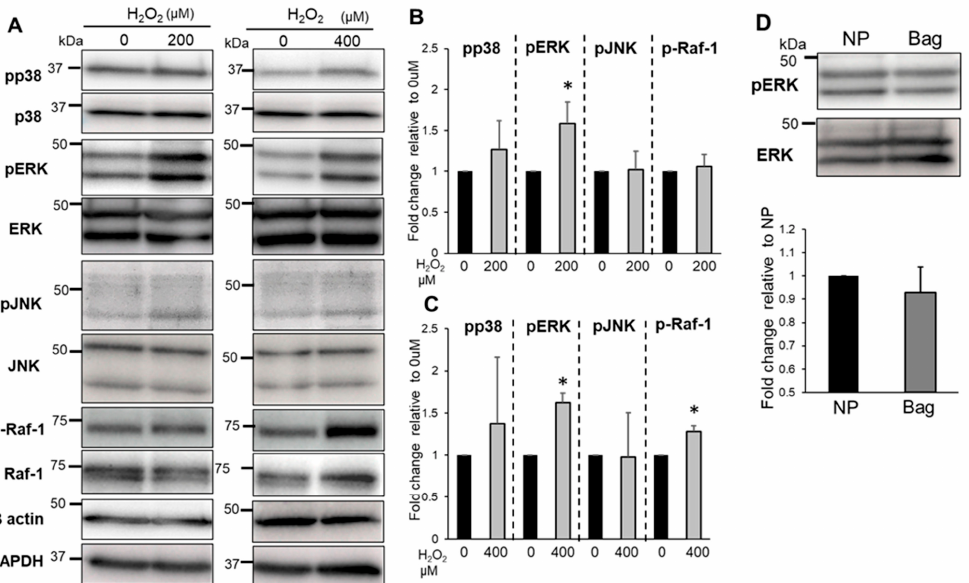
Figure 7. Evaluation of the phosphorylation of MAPK family members and Raf-1 in Bag-1-overexpressing NP cells. Western blot analysis ( A ) and quantification ( B , C ) of the phosphorylated forms of p38, ERK, JNK, and Raf-1 in NP cells treated with or without H 2 O 2 for 30 min. Data are the means ± SD n = 3, * p < 0.05. ( D ) Comparison of the expression of pERK in NP cells (NP) and Bag-1-overexpressing NP cells (Bag) without H 2 O 2 treatment. Data are the means ± SD n = 3, * p < 0.05.